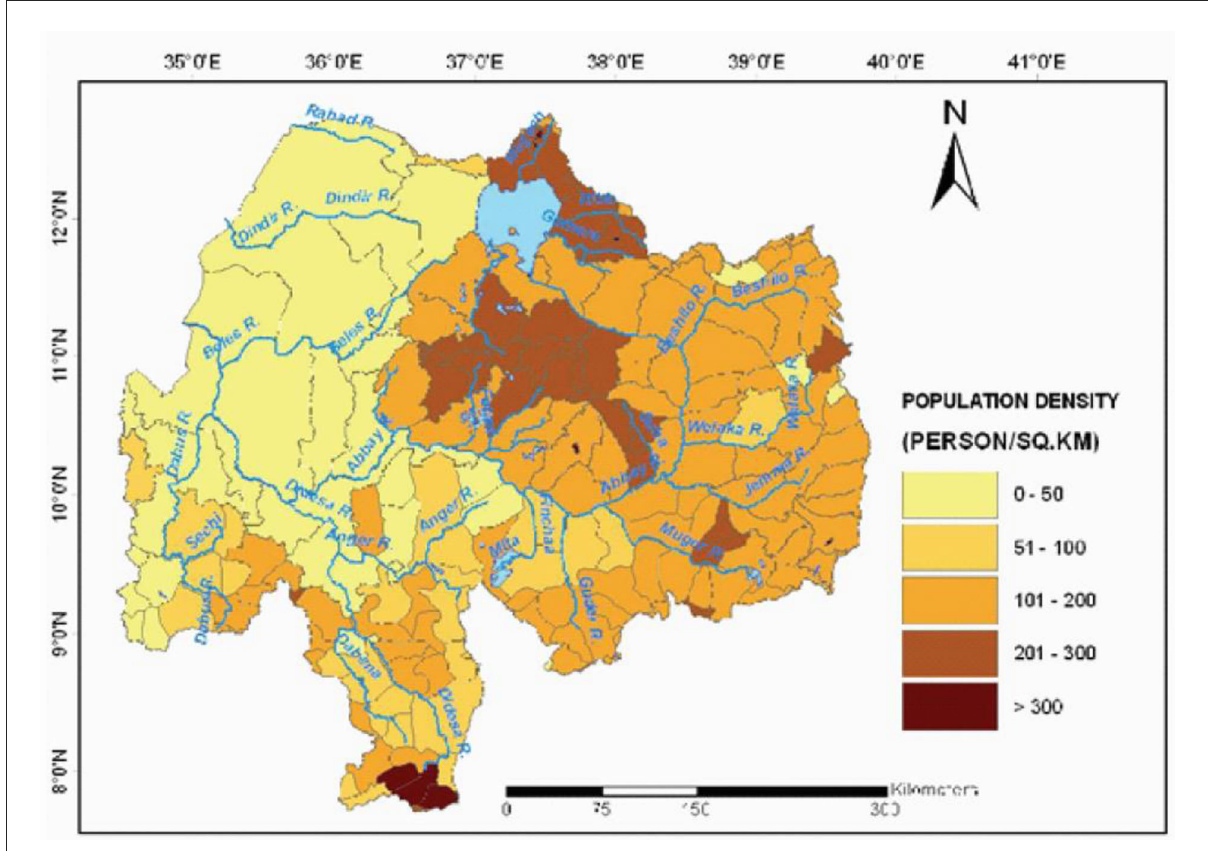
FIGURE9 Population density in the Abbay basin. Source (Central Statistical Agency (CSA), 2007, reproduced from Yilma and Awulachew,